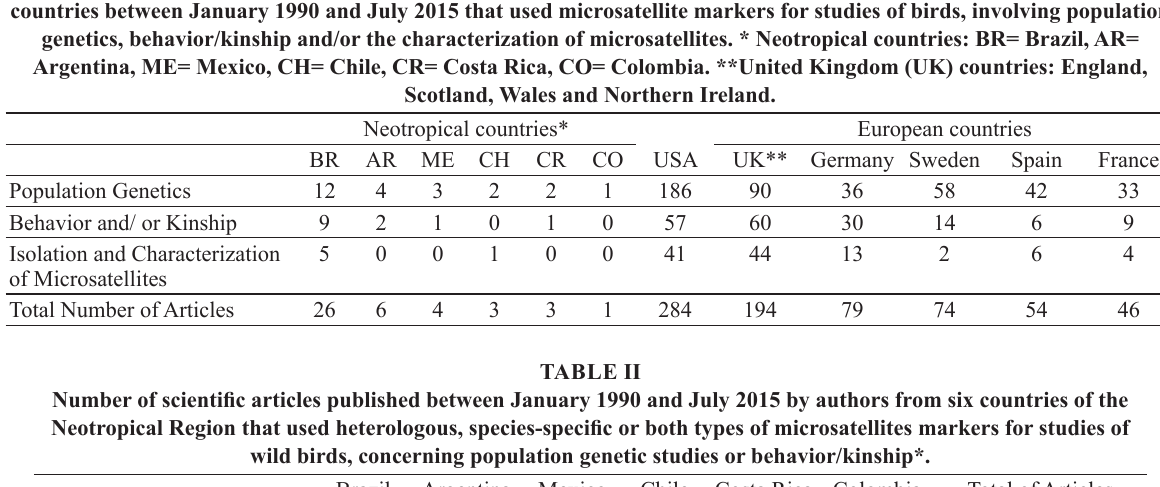
Total number of scientific articles published by authors from the Neotropical Region, USA and most productive European countries between January 1990 and July 2015 that used microsatellite markers for studies of birds, involving population genetics, behavior/kinship and/or the characterization of microsatellites. * Neotropical countries: BR= Brazil, AR= Argentina, ME= Mexico, CH= Chile, CR= Costa Rica, CO= Colombia. **United Kingdom (UK) countries: England,